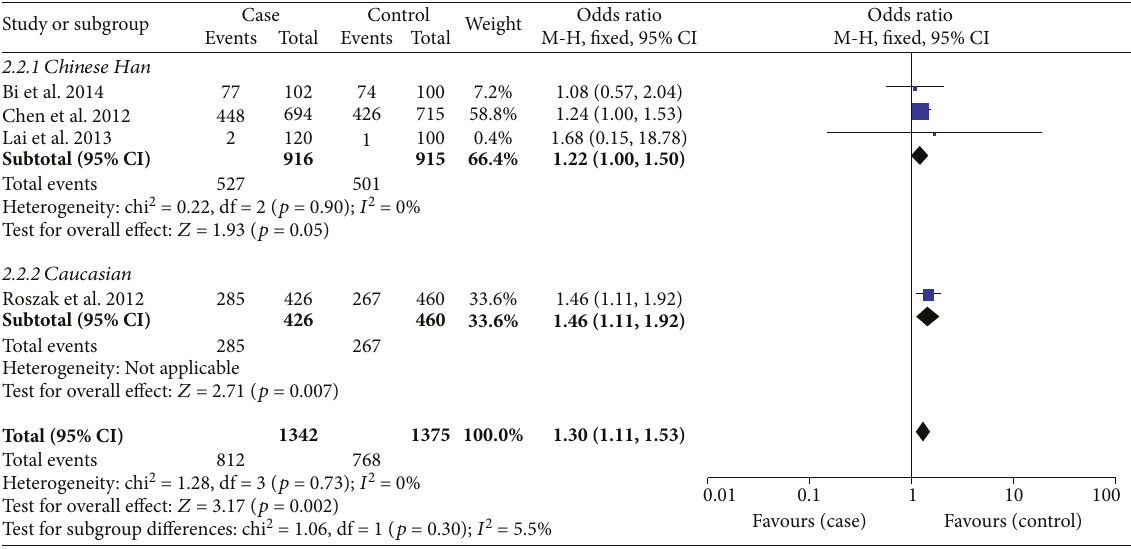
Figure 5: Subgroup analysis of the association between TLR9 rs187084 polymorphism and cervical cancer risk strati fi ed by race in the dominant genetic model.